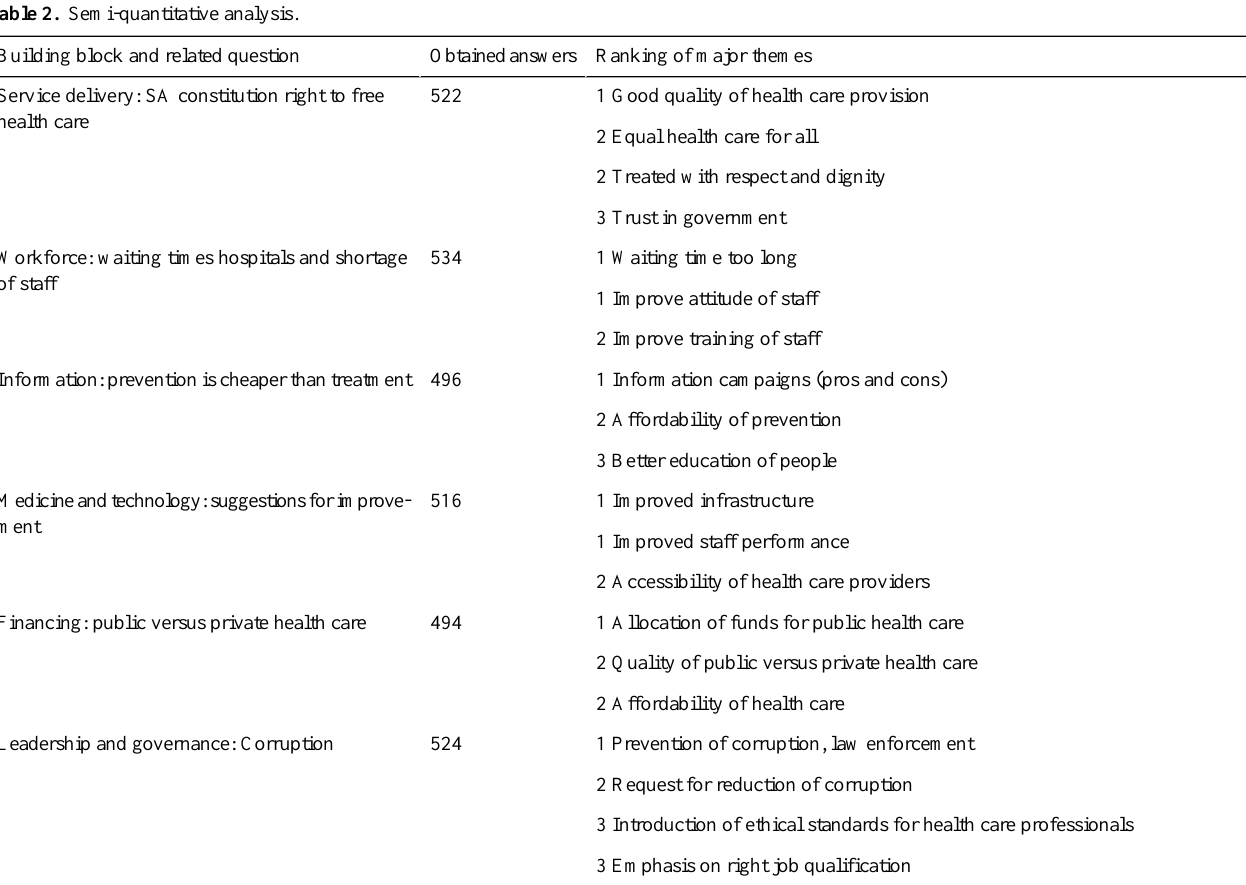
Table 2. Semi-quantitative analysis.